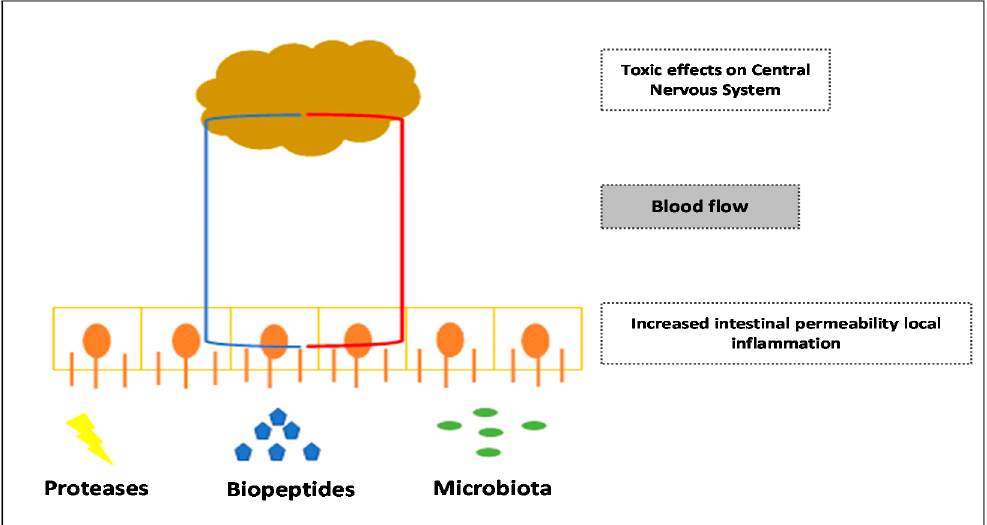
Figure 2. Microbiota-gut-brain axis in autism spectrum disorders.